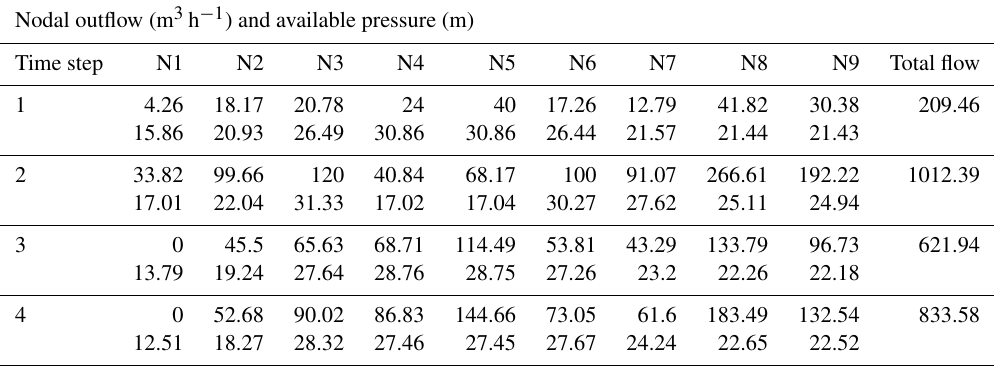
Table 7. Nodal outflows under pump 1 failure condition for multisource pumped network.